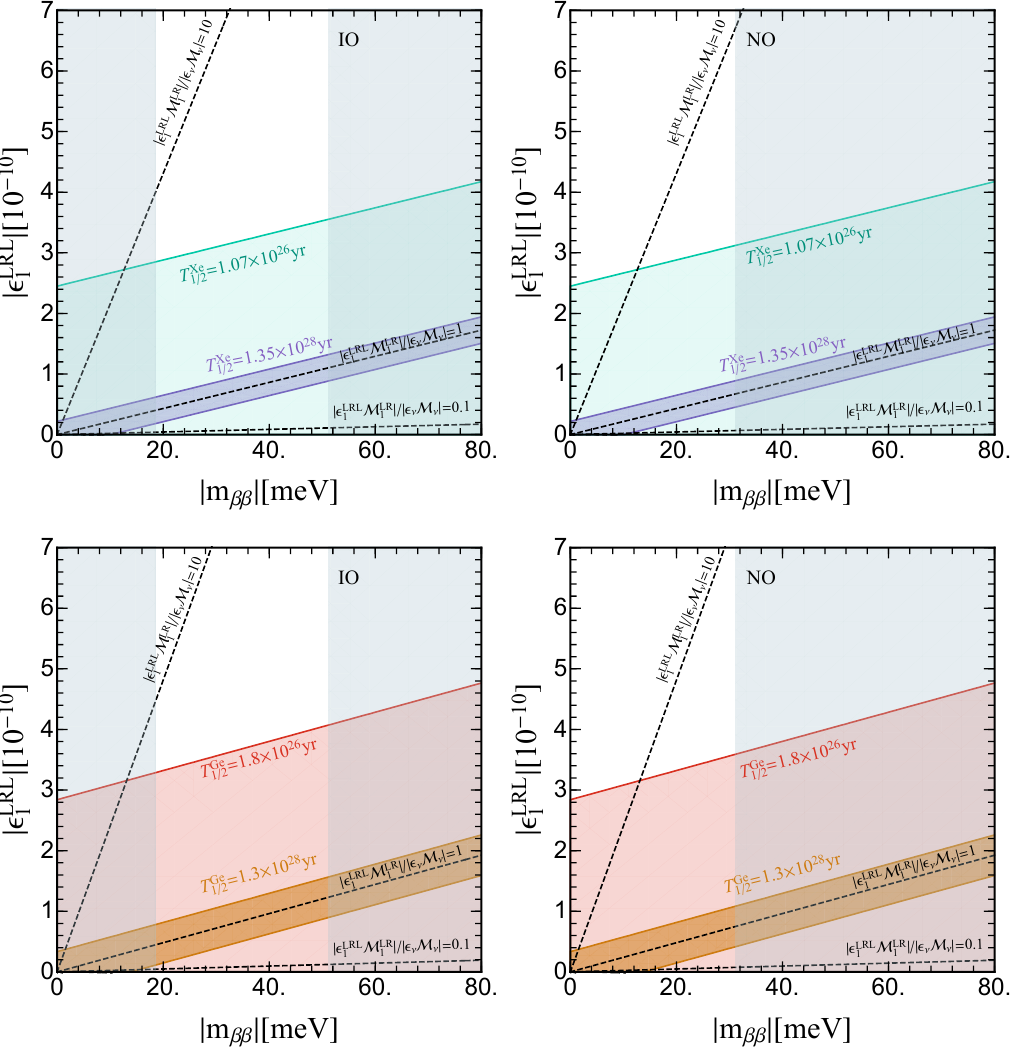
Figure 12 . Constraints on the effective neutrino mass | m ββ | and the short-range coupling (cid:15) LRL for 1 normal ordering and inverted ordering neutrino masses. The black dashed lines from top to bottom (cid:12) (cid:12) correspond to (cid:12) (cid:15) LRL 1 M LR 1 (cid:12) / | (cid:15) ν M ν | = 10 , 1 , 0 . 1 respectively. The highlighted regions represent the parameter space allowed by the current bounds T ( 76 Ge ) > 1 . 8 × 10 26 yr [38], T ( 136 Xe ) > 1 . 07 × 1 / 2 1 / 2 10 26 yr [3] and the future sensitivities T ( 76 Ge ) > 1 . 3 × 10 28 yr [4], T ( 136 Xe ) > 1 . 35 × 10 28 yr [5]. 1 / 2 1 / 2 The gray bands denote the regions excluded by the cosmological data P 3 m ν < 0 . 12 eV at 95% i =1 i confidence level from the Planck collaboration [44], and the oscillation parameters are fixed to the current best fit values